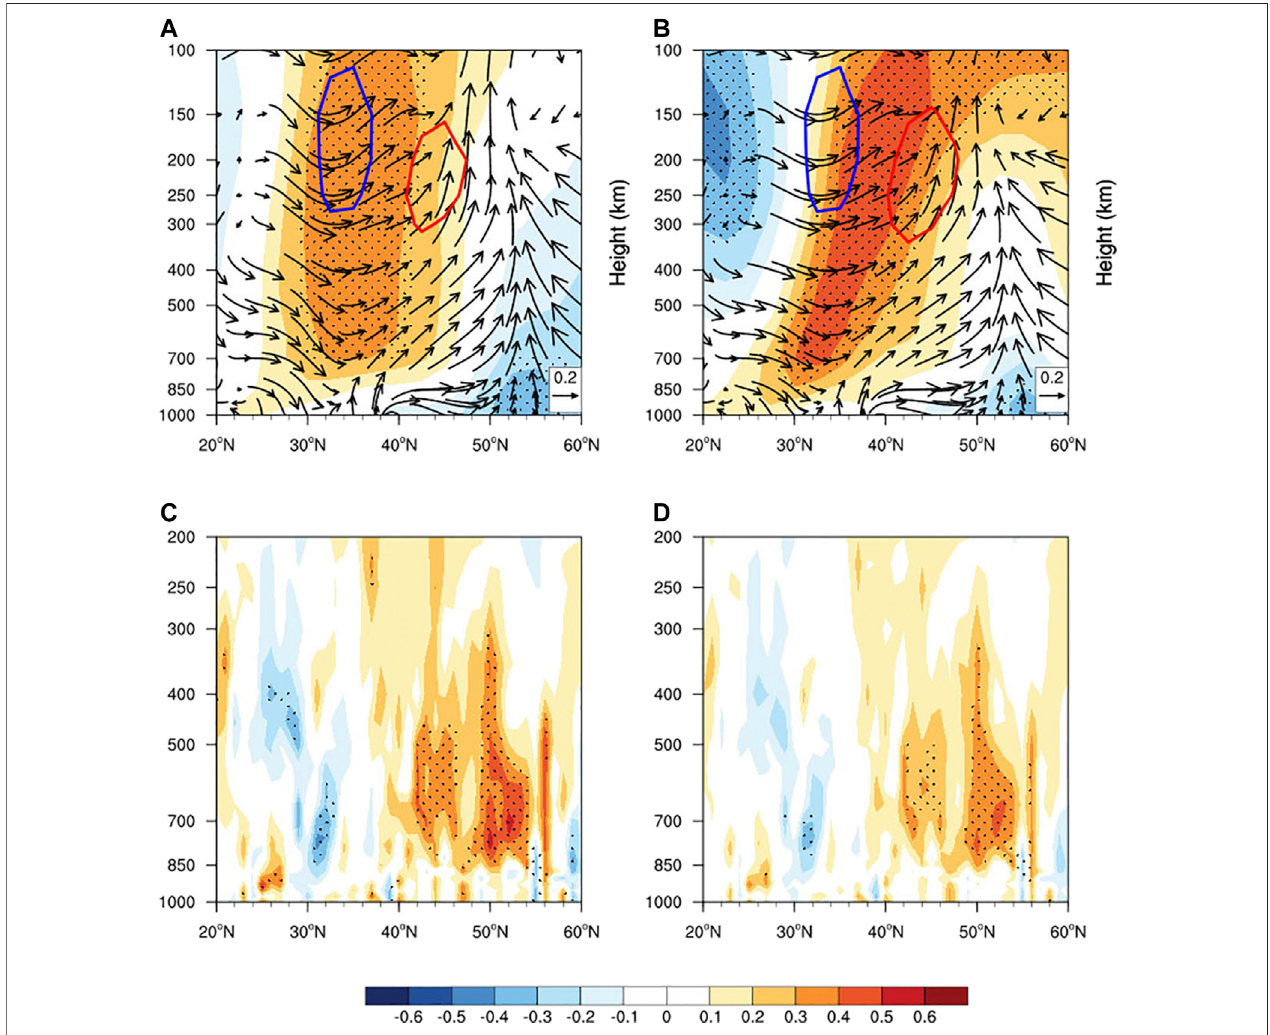
FIGURE7|(A,C) Correlationcoef fi cientsbetweenthePC1ofwinterNHsnowcoverandsummer (A) geopotentialheight(shading)andverticalcirculation(vectors), (C) relative vorticity along 115 ° N. (B,D) As in (A,C) but for the PC1 of summer CHDEs. The red lines in (A,B) represent 30 m/s zonal wind, which are regressed by high- value years of the PC1 of winter NH snow cover and summer CHDEs, and the blue lines are regressed by low-value years. Black dots and black vectors indicate values signi fi cant at the 95% con fi dence level. A positive correlation for meridional or upward wind component is denoted by an poleward or upward arrow, respectively.